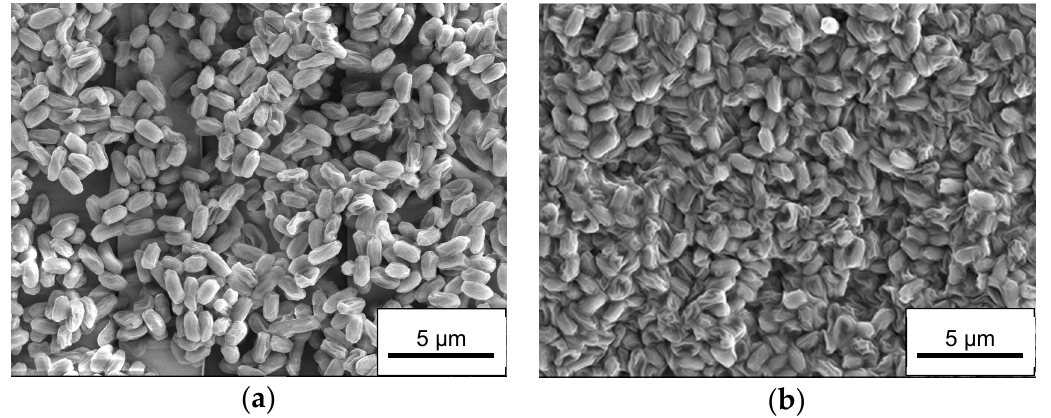
Figure 3. SEM pictures of ( a ) non-treated spores and ( b ) spores after sterilization process in correspondence to the impedimetric characterization at 7.0% v / v H 2 O 2 .